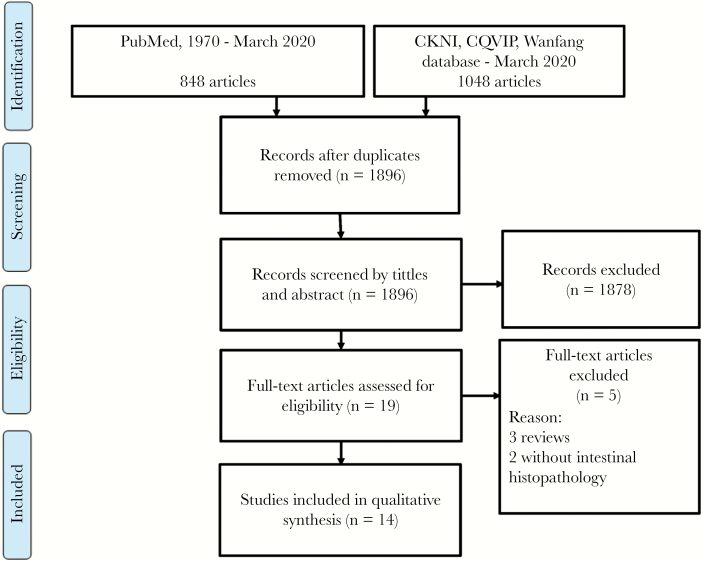
 PRISMA (2009) Flow diagram. CNKI, China National Knowledge Infrastructure; CQVIP, VIP Database for Chinese Technical Periodicals.